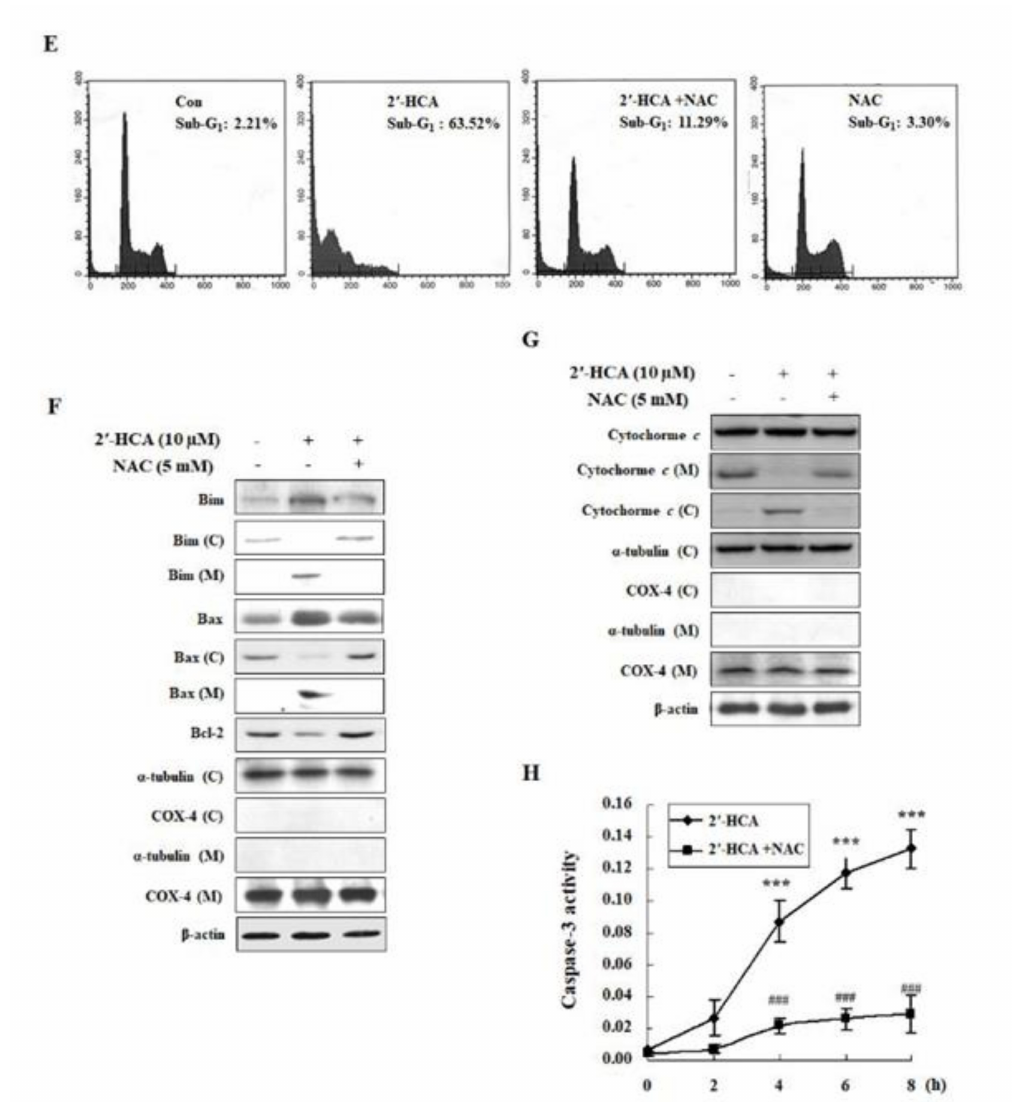
Figure 6. Effects of 2 (cid:48) -HCA on intracellular ROS production in HL-60 cells. ( A ) HL-60 cells were treated with 2 (cid:48) -HCA or H 2 O 2 for 5 min. ROS levels were determined with a DCFH-DA staining and the fluorescent intensity was measured by flow cytometry. ( B ) After pretreatment with 5 mM NAC for 1 h, HL-60 cells were treated with 10 µ M 2 (cid:48) -HCA for 5 min. The levels of intracellular ( C ) GSH and ( D ) PSH were determined in 2 (cid:48) -HCA-treated HL-60 cells ( • , 0 µ M; (cid:78) , 2.5 µ M; (cid:4) , 5 µ M; (cid:7) , 10 µ M 2 (cid:48) -HCA). After pretreatment with 5 mM NAC for 1 h, HL-60 cells were treated with 10 µ M 2 (cid:48) -HCA for 8 h, and ( E ) sub-G 1 and ( F , G ) mitochondria-related protein expression was detected by PI staining and western blotting, respectively. α -tubulin, COX-4, and β -actin were used as internal controls. ( H ) The effect of NAC on caspase-3 activity was examined in 2 (cid:48) -HCA-treated HL-60 cells. Data are presented as the mean ± SD of three independent experiments. * p < 0.05, *** p < 0.001 vs. control group, # p < 0.05, and ### p < 0.001 vs. 2 (cid:48) -HCA-treated